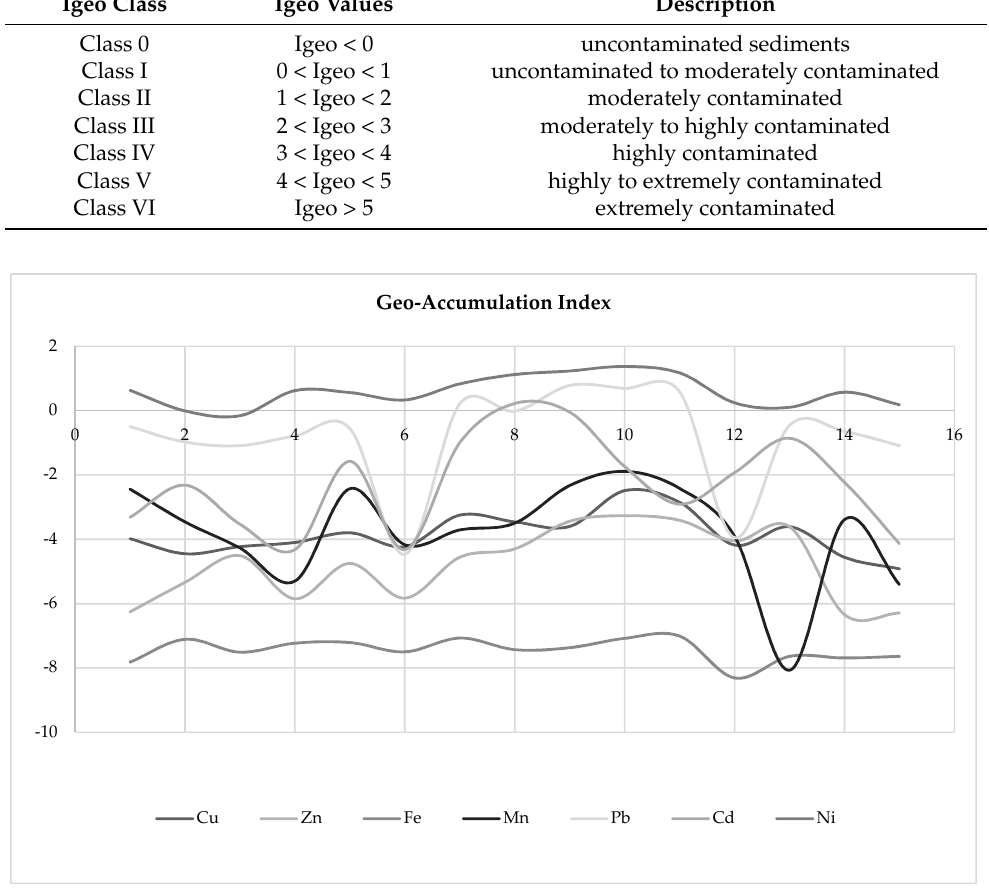
Figure 6. Igeo variation in the sediment of River Surma.